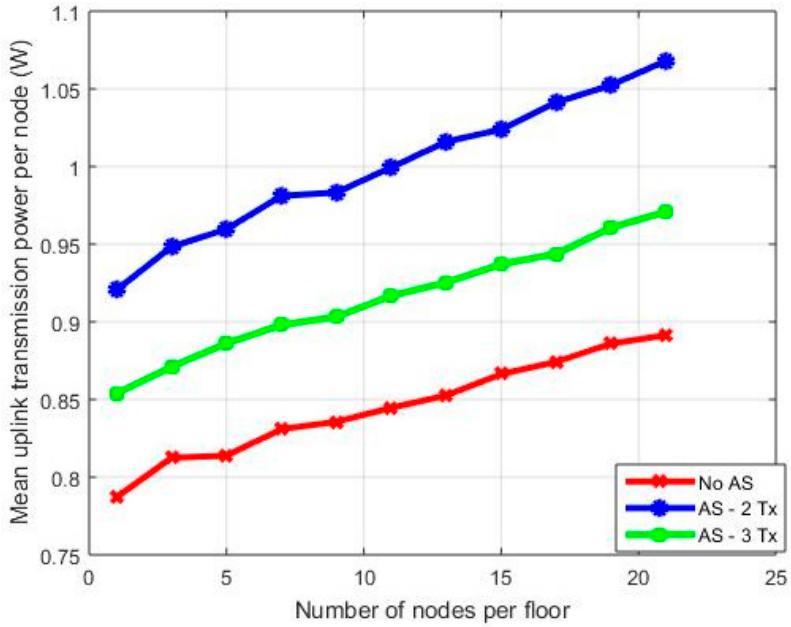
Figure 6. Mean power of nodes for various MIMO orientations with antenna selection—diversity combining transmission mode.